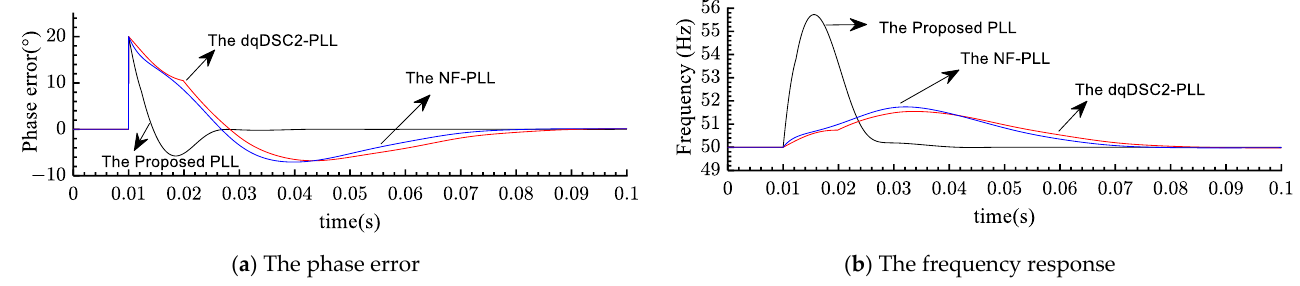
Figure 9. Comparisons between related PLLs under test1 condition: ( a ) the estimated phase error; and ( b ) the estimated frequency.